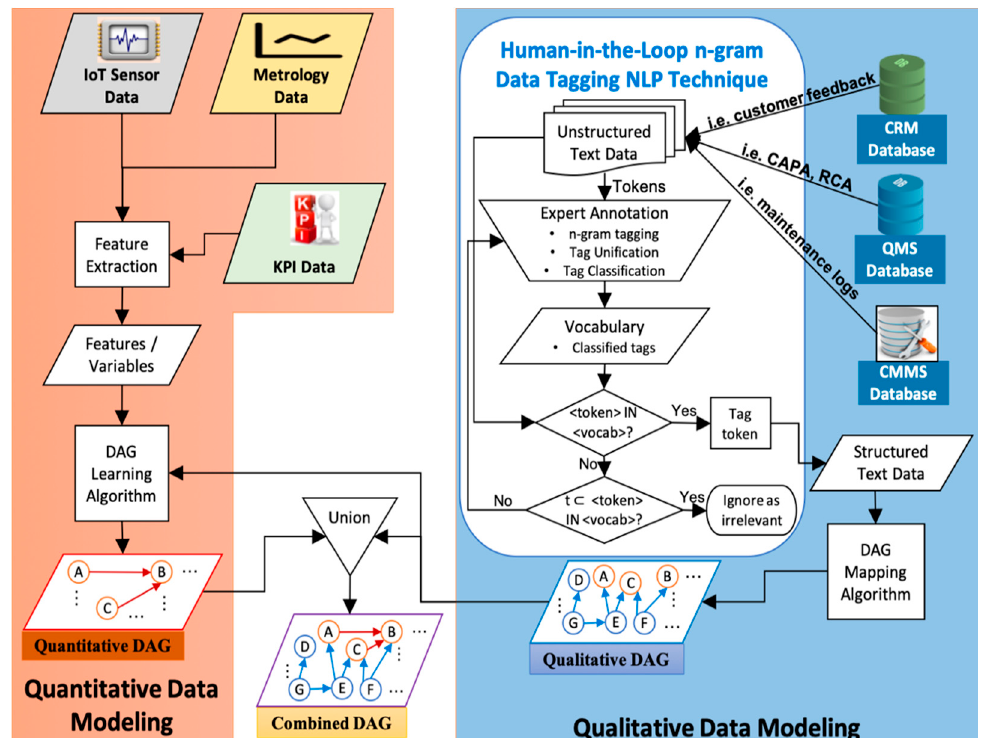
Figure 1. Fusion-learning flowchart.